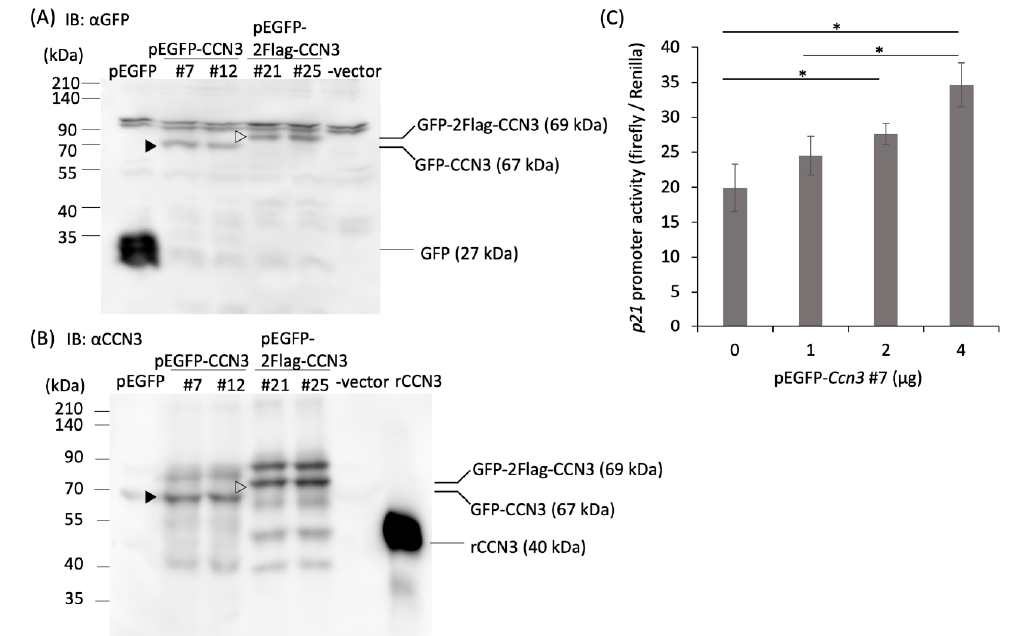
Figure 3. Induction of p21 promoter activity by overexpression of CCN3 in RCS cells. Detection of GFP-CCN3 ( ▶ ) and GFP-2Flag-CCN3 ( ▷ ) overexpression with ( A ) an anti-GFP antibody, and ( B ) anti-CCN3 antibody. Two days after transfection of pEGFP-CCN3 and pEGFP-2Flag-CCN3 vector (2 clones each) by electroporation, proteins were extracted from the cells and subjected to Western blot analysis. For the p21 promoter assay in ( C ), we used pEGFP-CCN3. ( C ) pEGFP-CCN3 vector, pGL3-PG12S containing p21 promoter with 12 × multiple p53-binding sites, and pGL3-Renilla vector were transfected by electroporation, and two days after transfection, firefly luciferase activity was monitored and standardized with Renilla luciferase activity (The data represent the mean ± SD ( n = 3 individual cultures); * p <